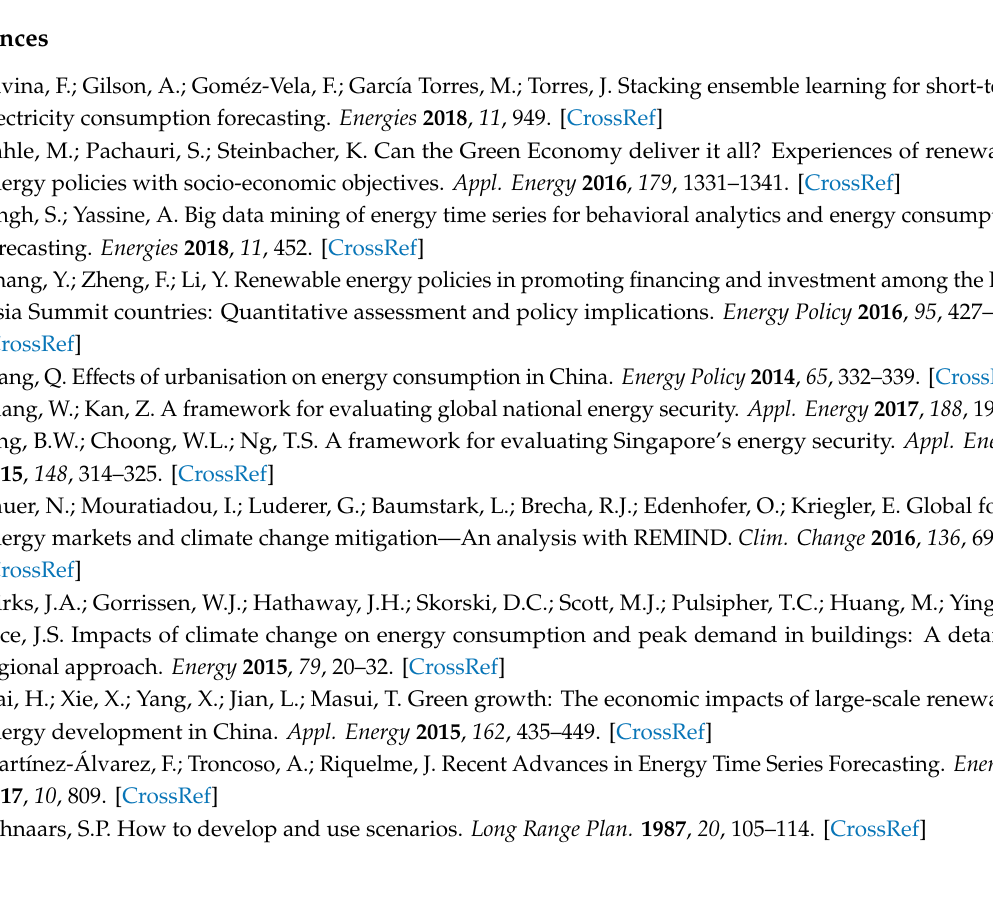
Figure A4. The interval prediction result of MSTA-GPR for China’s geothermal, biomass and other energy